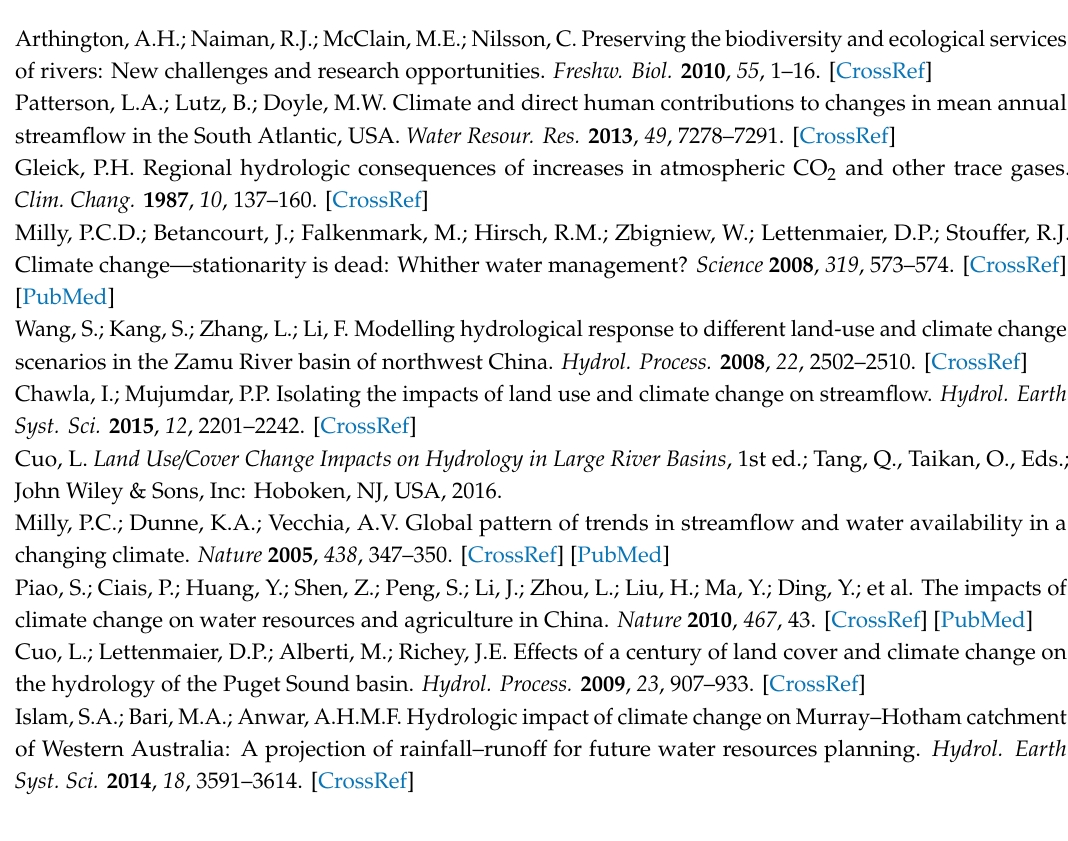
Figure S1: Conceptual representation (a) and flow chart (b) of the DHSVM. Figure S2: Change point detection of annual data. Mann–Kendall test on annual temperature at DT (T, (a)), moving t -test technique applied to annual temperature at DT (T, (b)), Mann–Kendall test on annual wind speed at DT (WS, (c)). Figure S3: Means and trends of monthly streamflow for simulation and observation at NC (2002–2016) and HL (1981–2016). Figure S4: Minimum and maximum temperature, wind speed for historical period 1966–2016, and climate 1966 for Datong station. Table S1: Transition matrix of land use in the Beichuan River Basin from 1980 to 2000 (km 2 ). Table S2: Transition matrix of land use in the Beichuan River Basin from 2000 to 2015 (km 2